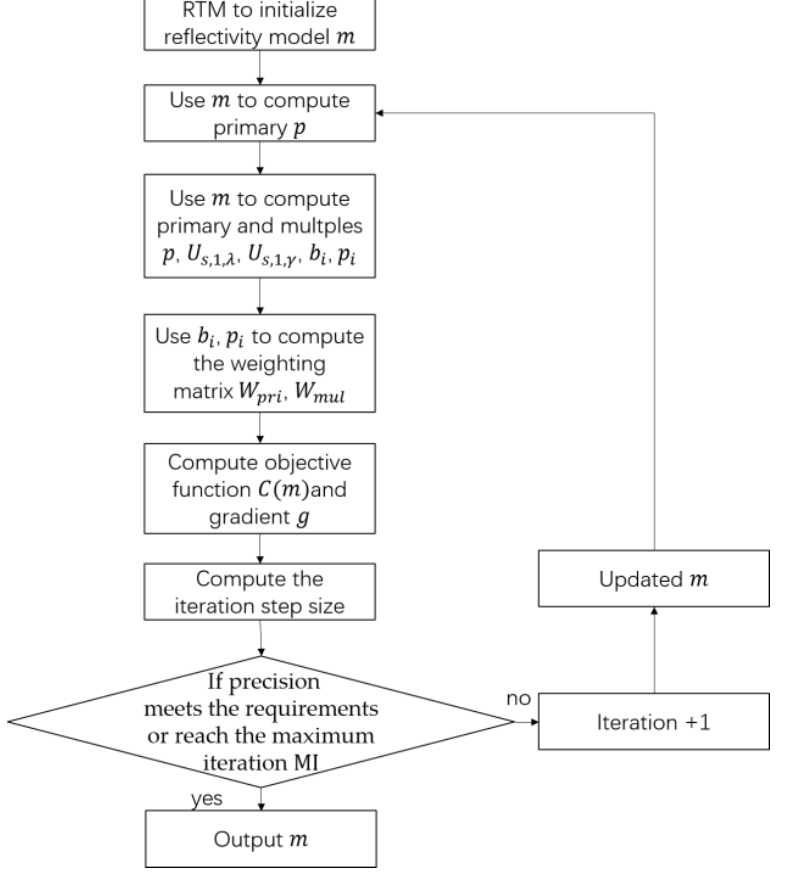
Figure 2. Flow chart of the LSRTM image of primary and internal multiples.